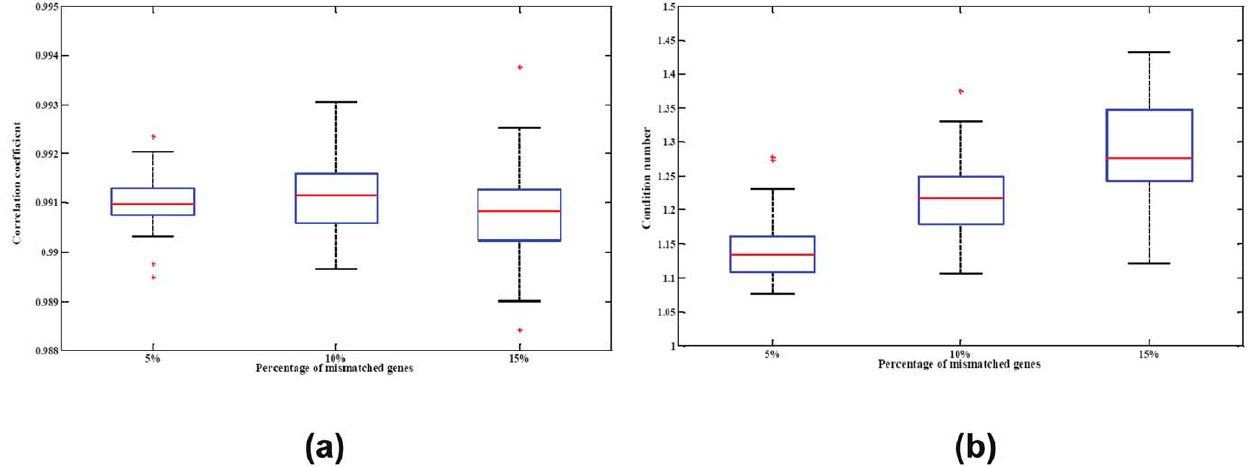
Figure 5. Stability of the signature matrix. (a) Boxplot displaying the stability of chosen signature matrix. The chosen signatures are distorted by randomly selecting 5, 10, or 15 percent of its genes and randomly modulating their values with 2 fold changes. The distribution of correlations between actual mixing fractions and fractions estimated using these signatures is depicted. (b) Condition number of the basis matrix with respect to the percentage of simulated differentially expressed genes in the basis